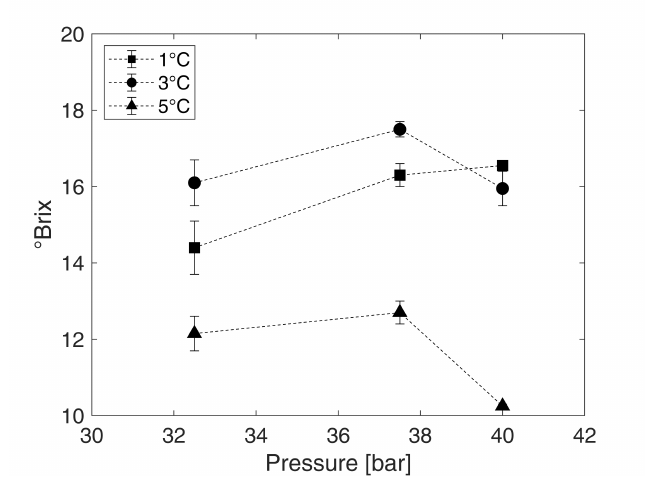
Figure 4. Reached sucrose content in °Brix in the concentrate produced from the water-sucrose model solution (10 °Brix) using CO 2 hydrate technology at pressures of 32.5 bar, 37.5 bar, and 40 bar combined with temperatures of 1 °C, 3 °C, and 5 °C (error bars: standard error of the mean according to Section 2.9, the standard errors of the mean are given in Table S2).